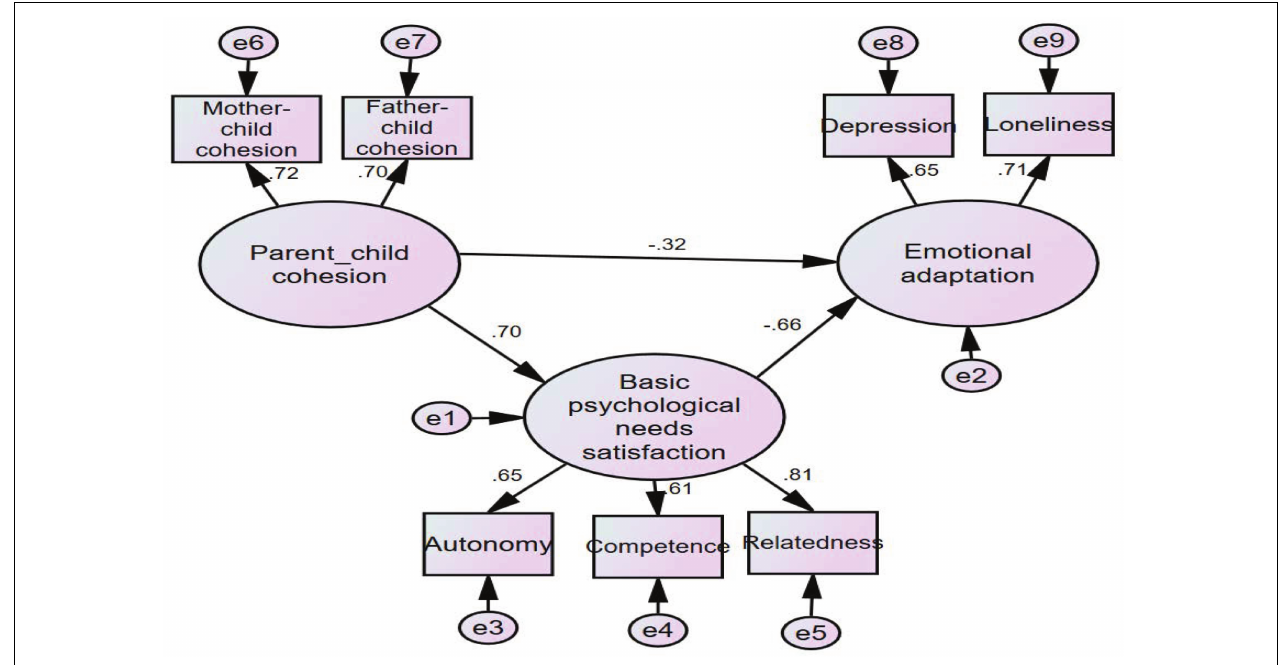
FIGURE 1 | Indirect effects model. Note: Only standardized regression coefficients are used in the figure, and P -values are all < 0.05.